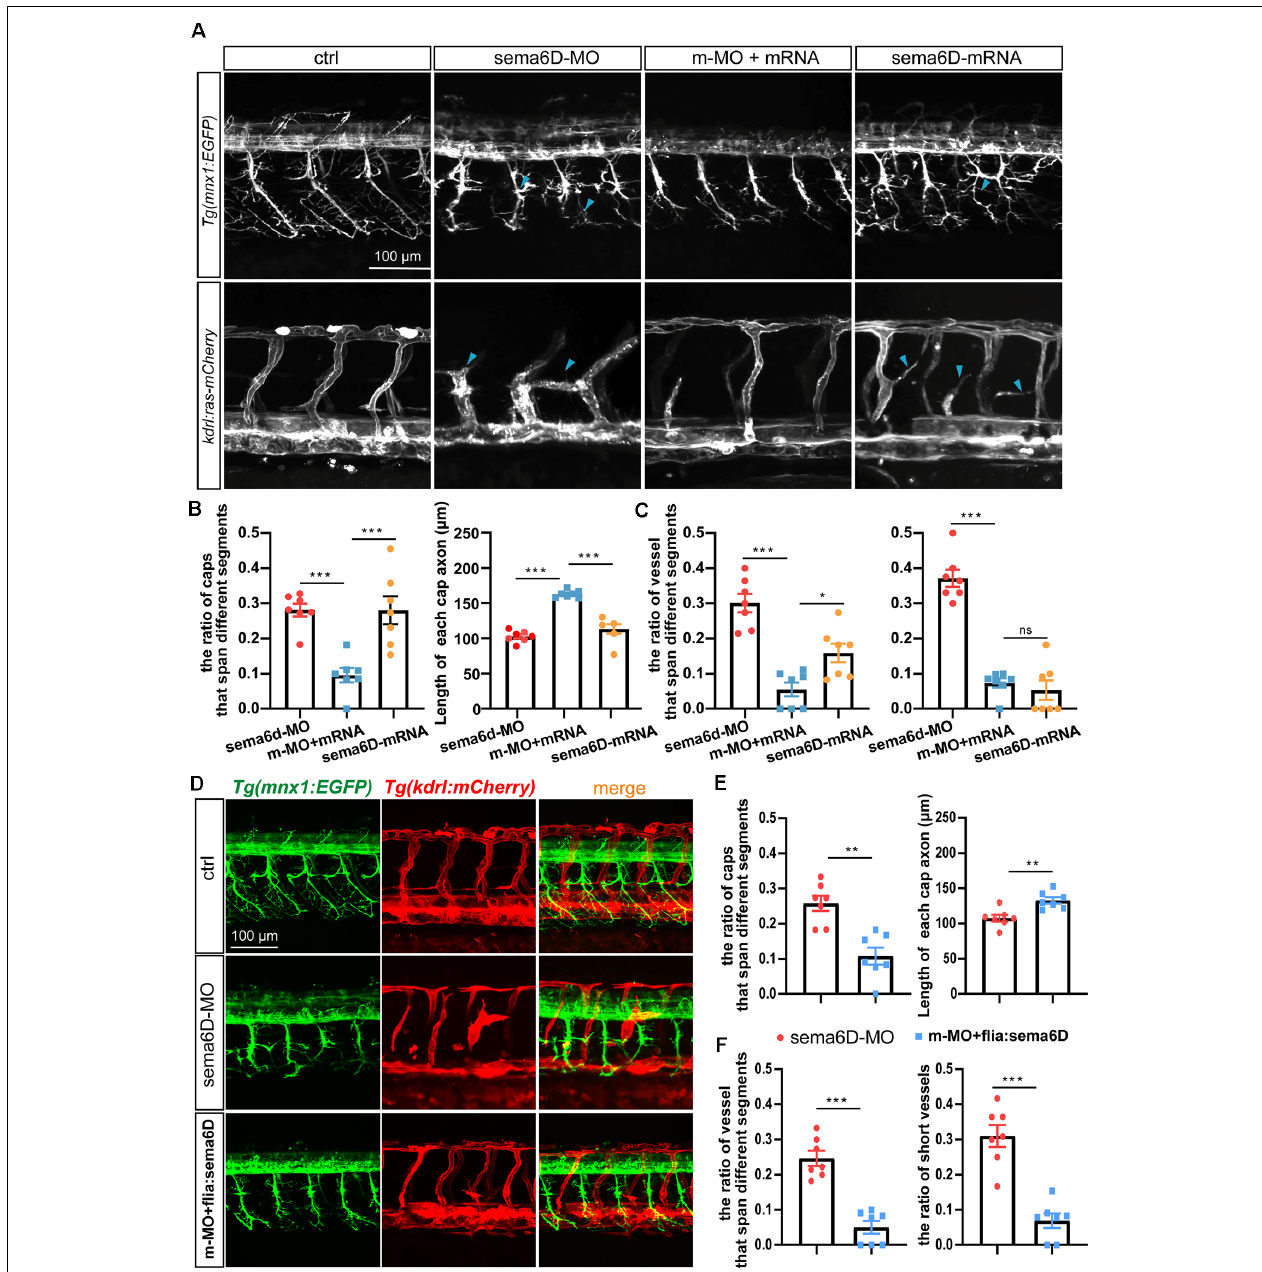
FIGURE 6 | Overexpressing sema6D partially restored the defects of PMNs and ISVs in sema6D -deficient embryos. (A) Confocal imaging analysis of PMNs and ISVs in control, sema6D -MO, and sema6D -mRNA injected embryos at 48 hpf. Blue arrowheads indicate aberrant PMNs and ISVs. (B) The statistical analysis of the ratio of aberrant axonal projection of Caps ( P = 0.0006) and short Caps ( P = 0.0006) in sema6D -MO, m-MO+ sema6D -mRNA, and sema6D -mRNA injected embryos at 48 hpf ( n = 7). About 9–11 caps were used for statistics per zebrafish. Mann-Whitney test. Values with *** above the bars are significantly different ( P < 0.001). (C) The statistical analysis of the ratio of vessel that span different segments (*** P = 0.0006; * P = 0.0291) and the ratio of ectopic vessels ( P = 0.0006) in the sema6D -MO, m-MO+ sema6D -mRNA, and sema6D -mRNA injected embryos at 48 hpf ( n = 7). About 9–12 ISVs were used for statistics per zebrafish. Mann-Whitney test. Values with *** above the bars are significantly different ( P < 0.001). Value with “ns” above the bars indicated no significantly different. (D) Confocal imaging analysis of PMNs and ISVs in control, sema6D morphants, and sema6D morphants with fli1a:sema6D plasmid at 48 hpf. (E) The statistical analysis of the ratio of aberrant axonal projection of Caps ( P = 0.0012) and the length of Caps ( P = 0.0047) in the sema6D morphants and sema6D morphants with fli1a:sema6D plasmid at 48 hpf ( n = 7). About 9–11 caps were used for statistics per zebrafish. Mann-Whitney test. Values with ** above the bars are significantly different ( P < 0.01). (F) The statistical analysis of the ratio of vessels that span different segments ( P = 0.0006) and the ratio of ectopic vessels ( P = 0.0006) in the sema6D morphants and sema6D morphants with fli1a:sema6D plasmid at 48 hpf ( n = 7). About 9–12 ISVs were used for statistics per zebrafish. Mann-Whitney test. Values with *** above the bars are significantly different ( P <